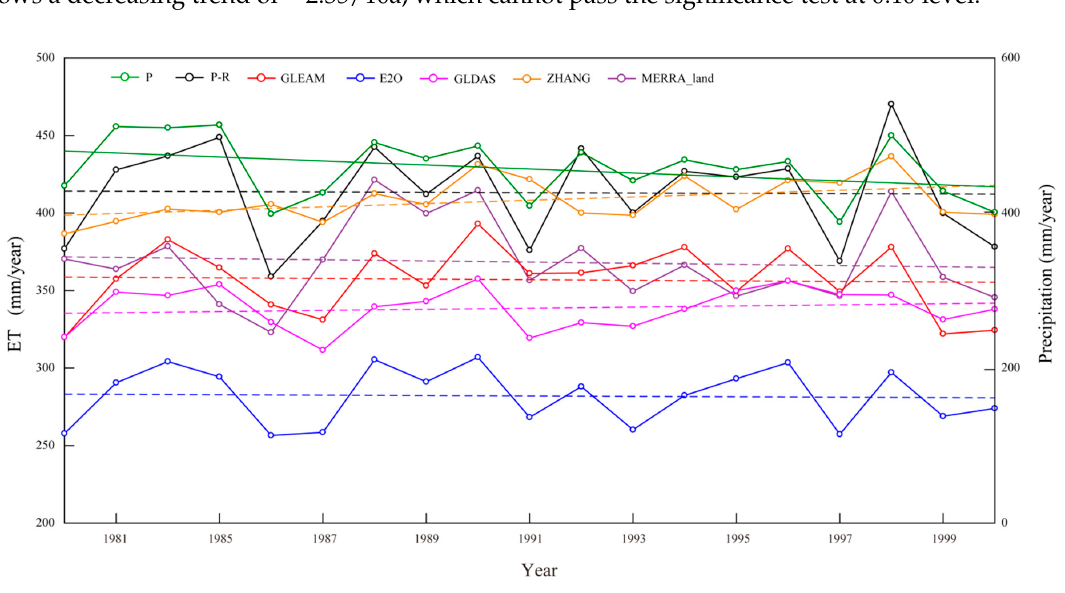
Figure 5. The interannual variations and trends of land ET from GLEAM, E2O, GLDAS, ZHANG, MERRA_land, and ET w , respectively, across the Yangtze River Basin. Table 3. Error metrics and linear trends of GLEAM, E2O, GLDAS, ZHANG, and MERRA_land products against water balance evapotranspiration (ETw) across the Yellow River Basin. The asterisk (*) indicates passing the significance test at the 0.10 level, and the asterisk (**) indicates passing the significance test at a 0.05 level.